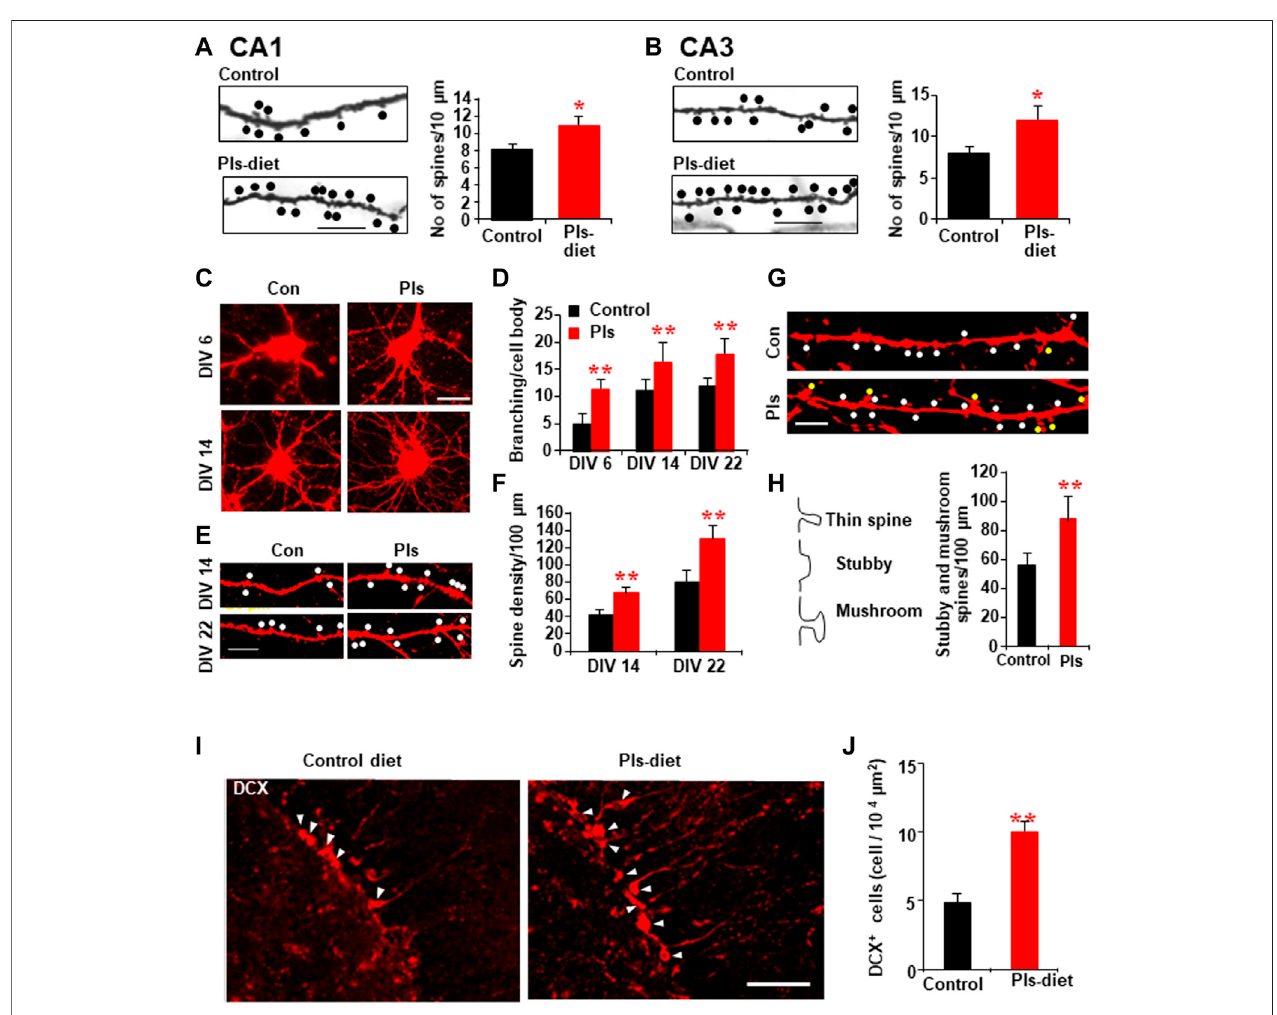
FIGURE 5 | PLs-induced increase in dendritic spines in vivo and in vitro. (A,B) Golgi-cox staining shows the representative dendritic-like spines (dots) of CA1 (A) and CA3 neurons (B) in control and Pls diet mice. Quanti fi cation data show the changes in the number of spines in Pls diet mice. Scale bar, 10 μ m. (C – H) Effects of Pls (5 μ g/ml)applicationontheculturedneuronalcells.NeuronalcellsderivedfromE18miceembryowereculturedwithPls-containingmediumfortheindicateddays(DIV= disc invitro culture)andstainedbyDiltovisualize(redcolor)themorphologyofthecells.PlswereaddedontheDIV3.Branchingpercellbody (C,D) andthenumber of spines (dots) were enhanced by Pls (E,F) . The stubby spines (white dots) and mushroom-shaped spines (yellow dots) were also enhanced by Pls (G,H) . Scale bar, 20 μ m. (I) Immunohistochemistry data show the increased amount of doublecortin (DCX) positive neurons (arrowheads) in the dentate gyrus of Pls diet mice hippocampus.Scalebar,50 μ m. (J) Quanti fi cationdataofpanel (I) showthesigni fi cantincreaseintheDCX-positiveneuronsinPlsdietmice.Thedatarepresentmean± S.E.M. These values were drawn from the three independent experiments with triplicates. For each sample, more than 20 different locations were photographed by the microscope(40and 60X)and scoredthespines numberper unitlengthand branchingpercellbody. *, p < 0.05and **, p < 0.01.The p valuesinpanelsofDand Fwere calculated by ANOVA followed by Bonferroni ’ s post hoc tests whereas Student ’ s t-tests were performed in panels (A,B,H,J) .